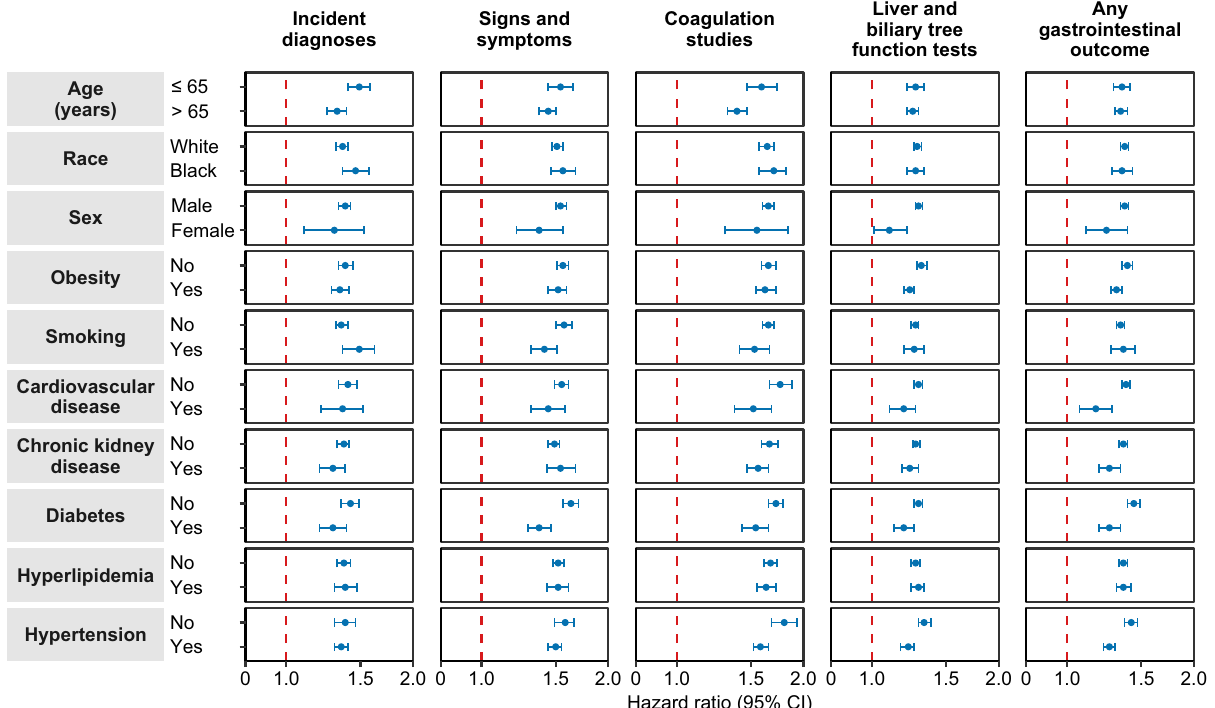
positive test until the end of follow-up. COVID-19 cohort ( n = 154,068) and con- temporary control cohort ( n = 5,638,795). Adjusted HRs (dots) and 95% (error bars)CIsarepresented.ThedashedlinemarksaHRof1.00;lowerlimitsof95%CIs with values greater than 1.00 indicate signi fi cantly increased risk. GERD gastro- esophageal re fl ux disorder, IBS irritable bowel syndrome, PT prothrombin time, PTT partial thromboplastin time, INR international normalized ratio, ALT alanine transaminase, AST aspartate transaminase, LDH lactate dehydrogenase, CRP c-reactive peptide, ALP alkaline phosphatase, GGT γ -glutamyl